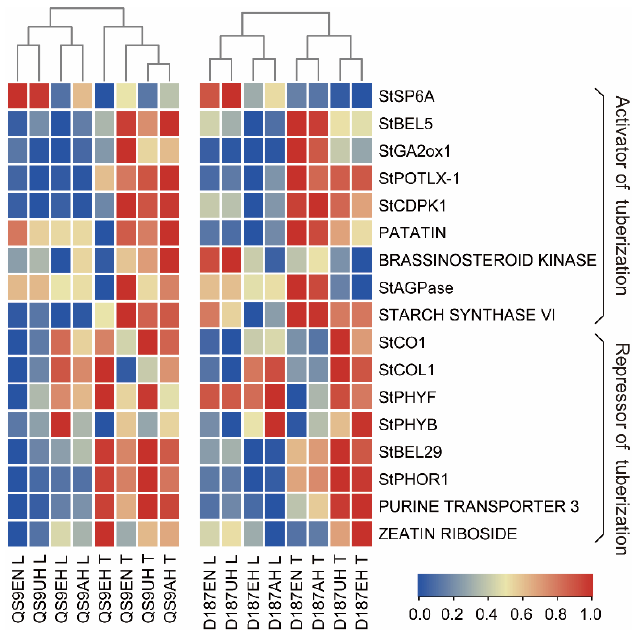
Figure 7. The expression of the selected genes from the transcriptome analysis. Expression of the candidate genes involved in temperature-dependent tuberization. Red to blue indicates expression from high to low. The colour scale represents log 2 (FPKM+1).